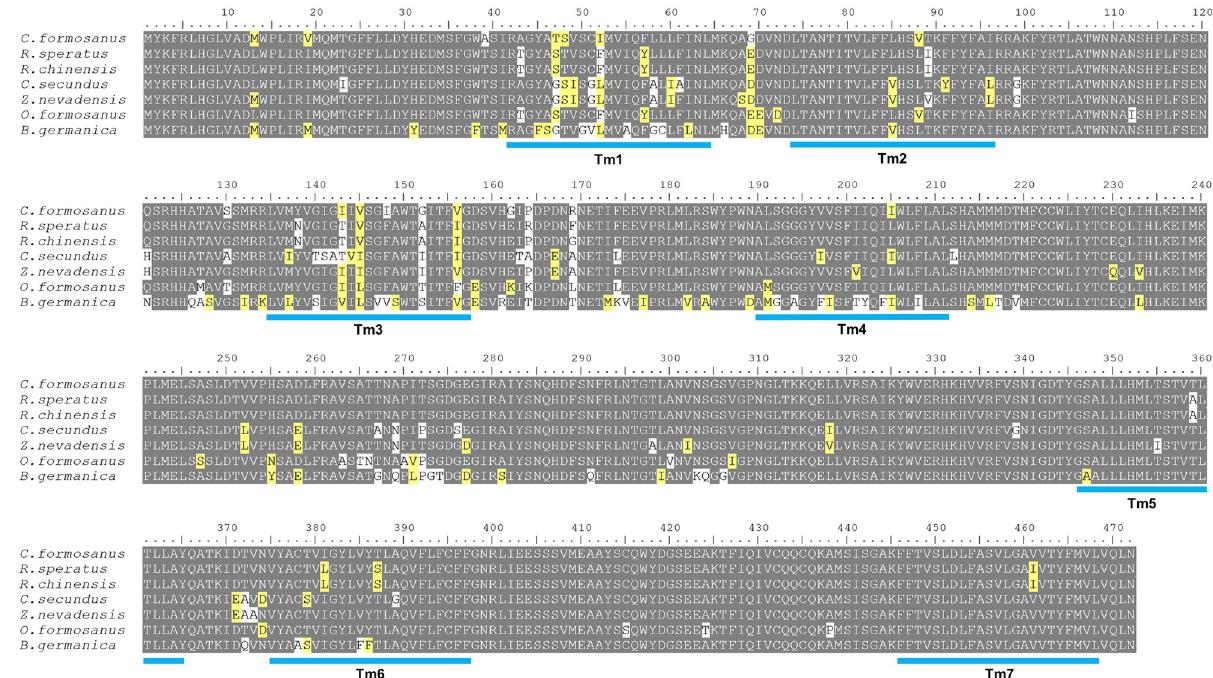
Fig 1. Alignment of Orco proteins in C . formosanus and other Blattodea species. Conserved regions are shown in gray background, and mismatches above or below 50% are shown in yellow and white backgrounds, respectively. The predicted 7tm_6 transmembrane domains (Tm1-7) are denoted with cyan-colored